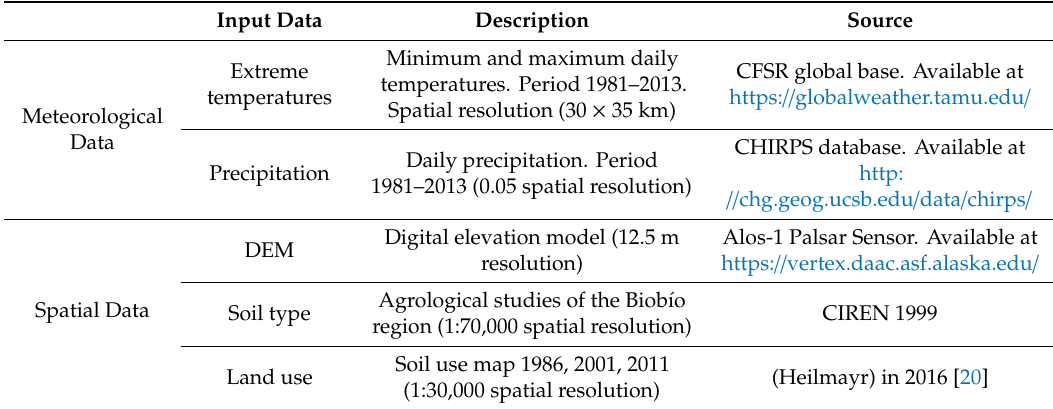
Table 1. Input variables used for SWAT